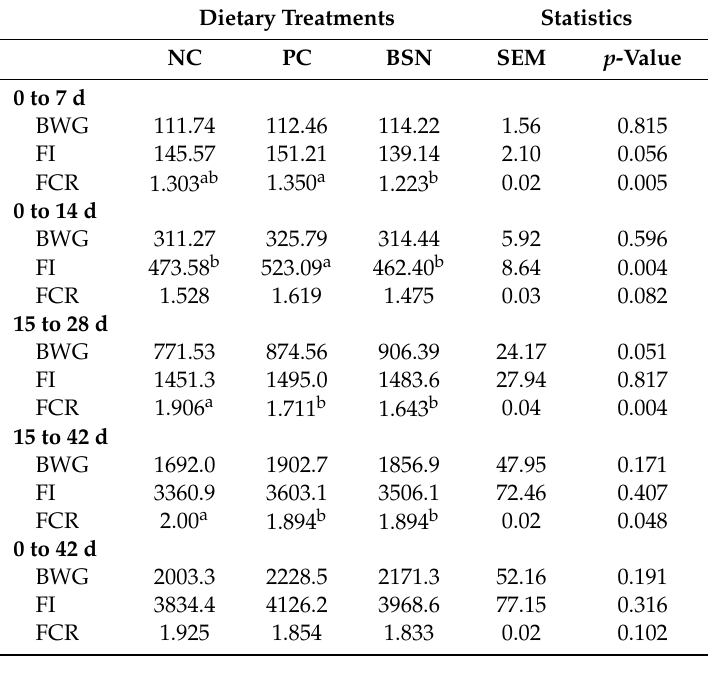
Table 1. E ff ects of dietary non-drug feed additive (BSN) on body weight gain (g / bird), feed intake (g / bird), and feed conversion ratio (g / g bird) of the experimental birds.